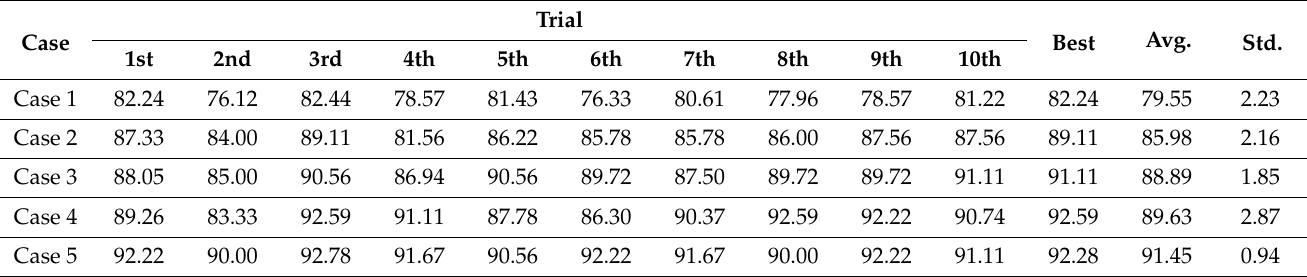
Table 3. Recognition accuracy with reference and eye-written data together for the comparative